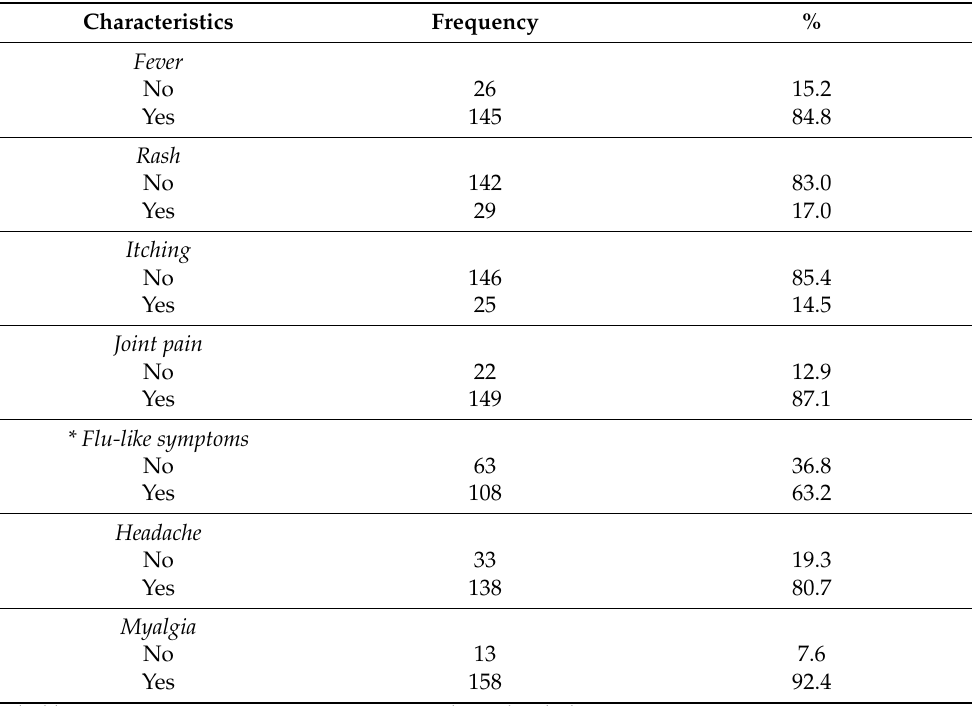
Table 2. Clinical features of viral infections among pregnant women in Mwanza.